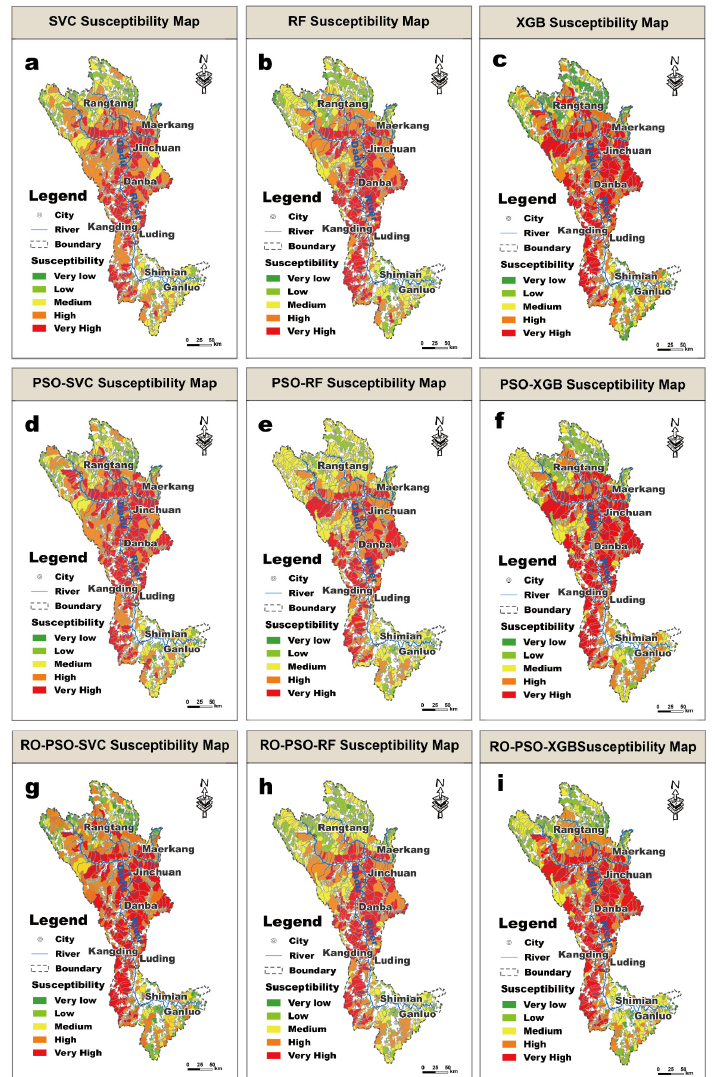
Figure 10. The debris flow susceptibility maps of the Dadu River based on the ( a ) SVC, ( b ) RF, ( c )